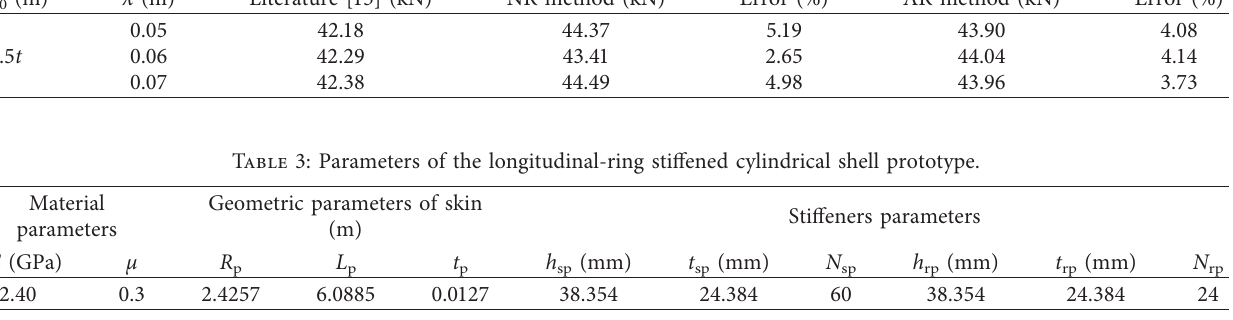
Table 4: Parameters of the completely similar model of the longitudinal-ring stiffened cylindrical shell. Material parameters